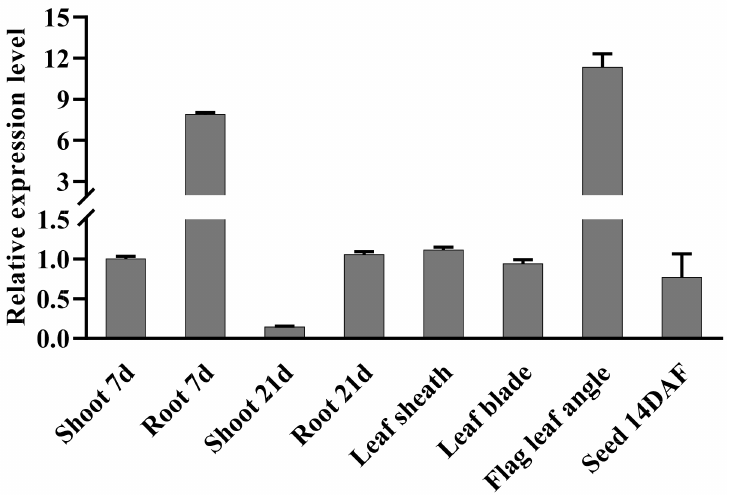
Figure 1. The expression level of OsbHLH024 in eight different tissues. OsUBQ5 was used as the control; three biological replicates were applied, and the values were expressed as means ±